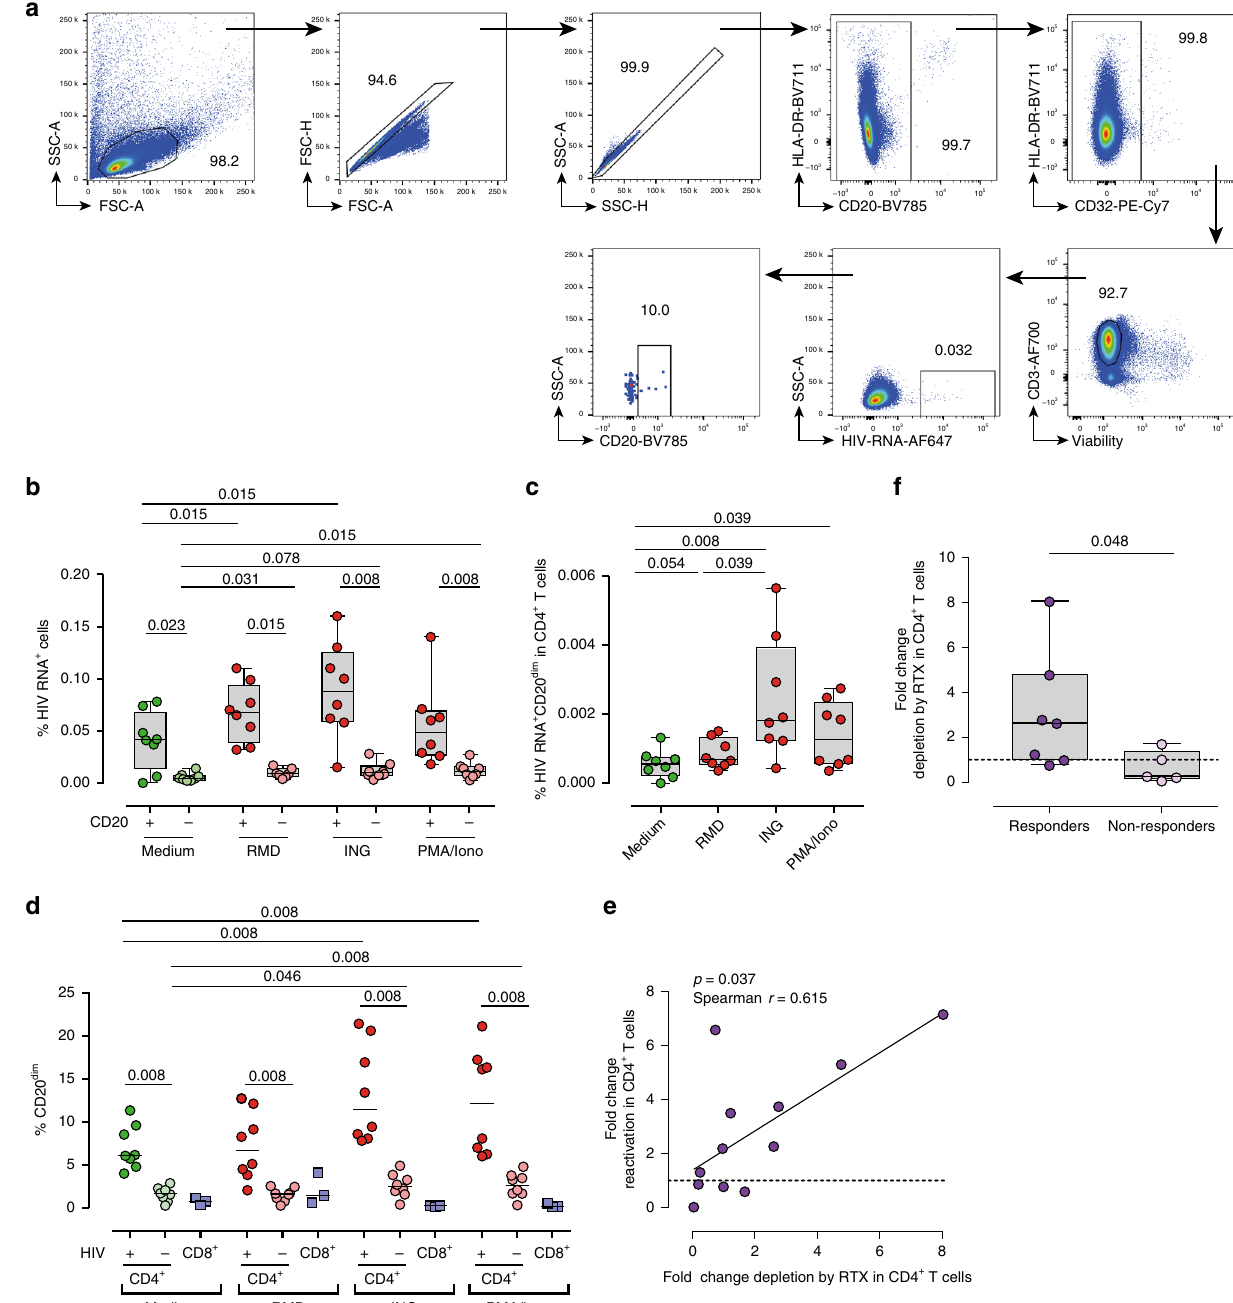
Fig. 8 Rituximab impacts pharmacologically HIV-reactivated cells. a – c Freshly isolated CD4 + cells from (#33 – 40) and CD8 + cells (#17 – 19) from n = 8 and n = 3 ART-suppressed patients, respectively, were treated with romidepsin (RMD), ingenol (ING), or PMA/ionomycin (PMA/Iono) for 22 h and subjected to the RNA FISH- fl ow assay for the detection of HIV RNA transcripts. a Representative fl ow gating strategy used for the analysis. Proportions of cells expressing HIV RNA within CD20 dim and CD20-negative CD4 + T cells ( b ) or cells expressing HIV RNA and CD20 dim in CD4 + T cells ( c ) are shown. Medians and min – max rank are represented. The median percentages of CD20 dim in infected and uninfected CD4 + T cells, and CD8 + T cells after treatment with different LRAs are shown in ( d ). Comparisons were performed using the Wilcoxon test. e , f Unfractionated PBMCs from n = 12 ART- suppressed patients (#18, 19, 21, 23, 41 – 48) were treated with the latent reversal agents (LRAs) romidepsin or panobinostat for 24 h, and with Rituximab for 48 h. HIV RNA expression were measured by qPCR. Panel ( e ) shows the correlation between the fold-change reactivation by the LRA and the fold- change cell depletion by Rituximab. Spearman ’ s nonparametric correlation coef fi cient and associated p value are shown. Panel ( f ) shows the fold-change in cell depletion by Rituximab in patients, strati fi ed by responders (fold-change reactivation by LRA > 1) and non-responders (fold-change reactivation by LRA < 1). The Mann – Whitney test was used for statistical analyses in all panels. Median and min – max ranks are represented in all panels. Data underlying